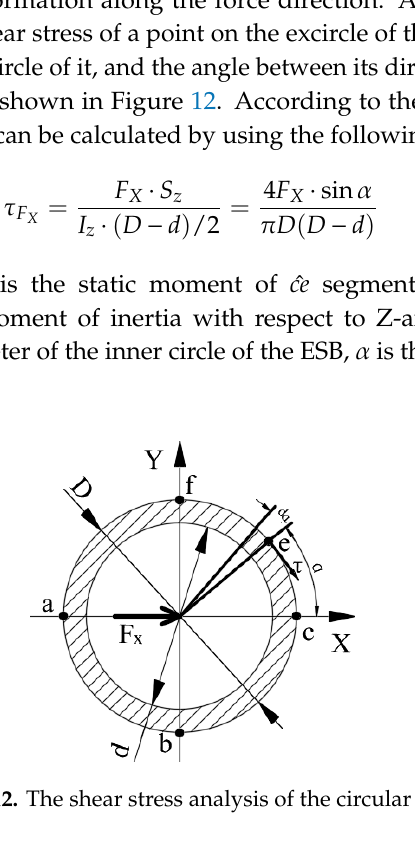
Figure 12. The shear stress analysis of the circular ring.